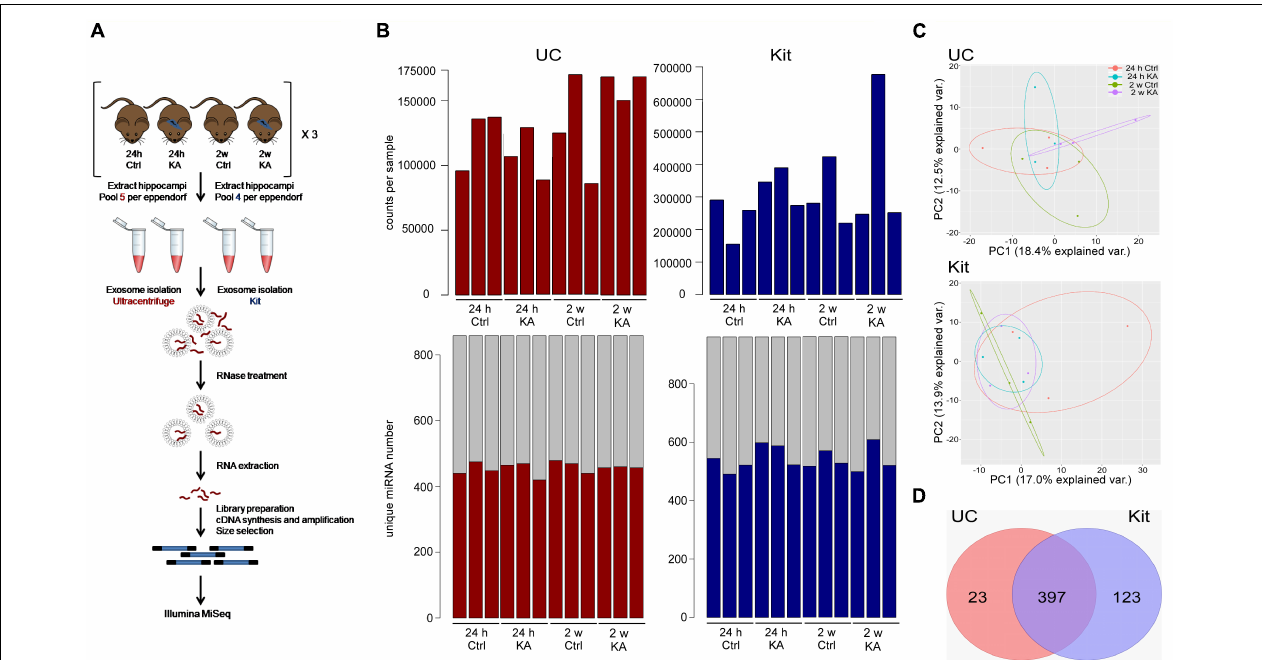
FIGURE 5 | Study design and sequencing of EEF miRNAs. (A) Schematic of experimental design for miRNA sequencing. EEFs were prepared using hippocampi from sets of control (Ctrl) or KA-treated mice using UC- or kit-based methods. EEFs were then RNAse treated to remove non-enclosed miRNAs and processed for RNA sequencing. (B) Top: bar plot showing total number of counts per sample mapping to miRBase_V21. Bottom: Number of confidently called, unique miRNA identified in each sample. (C) Principal component analysis (PCA) plot showing clustering of the 420 and 520 filtered miRNAs from UC and kit samples, respectively. (D) Venn diagram shows the number of detected miRNAs in exosomes post filtration in UC and in kit, highlighting EEF miRNAs common to both